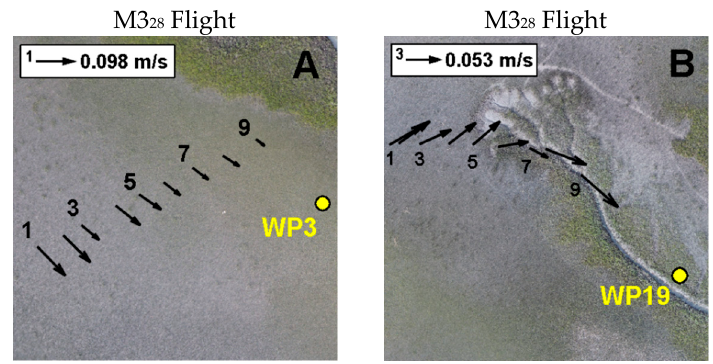
Figure 11. ( A ) Surface water velocities are progressively reduced with the increase in vegetation height and density approaching a tidal creek; ( B ) Water flows are entering a creek-head in the ebb phase. The black arrows describe the non-interpolated velocities obtained from the dye survey.